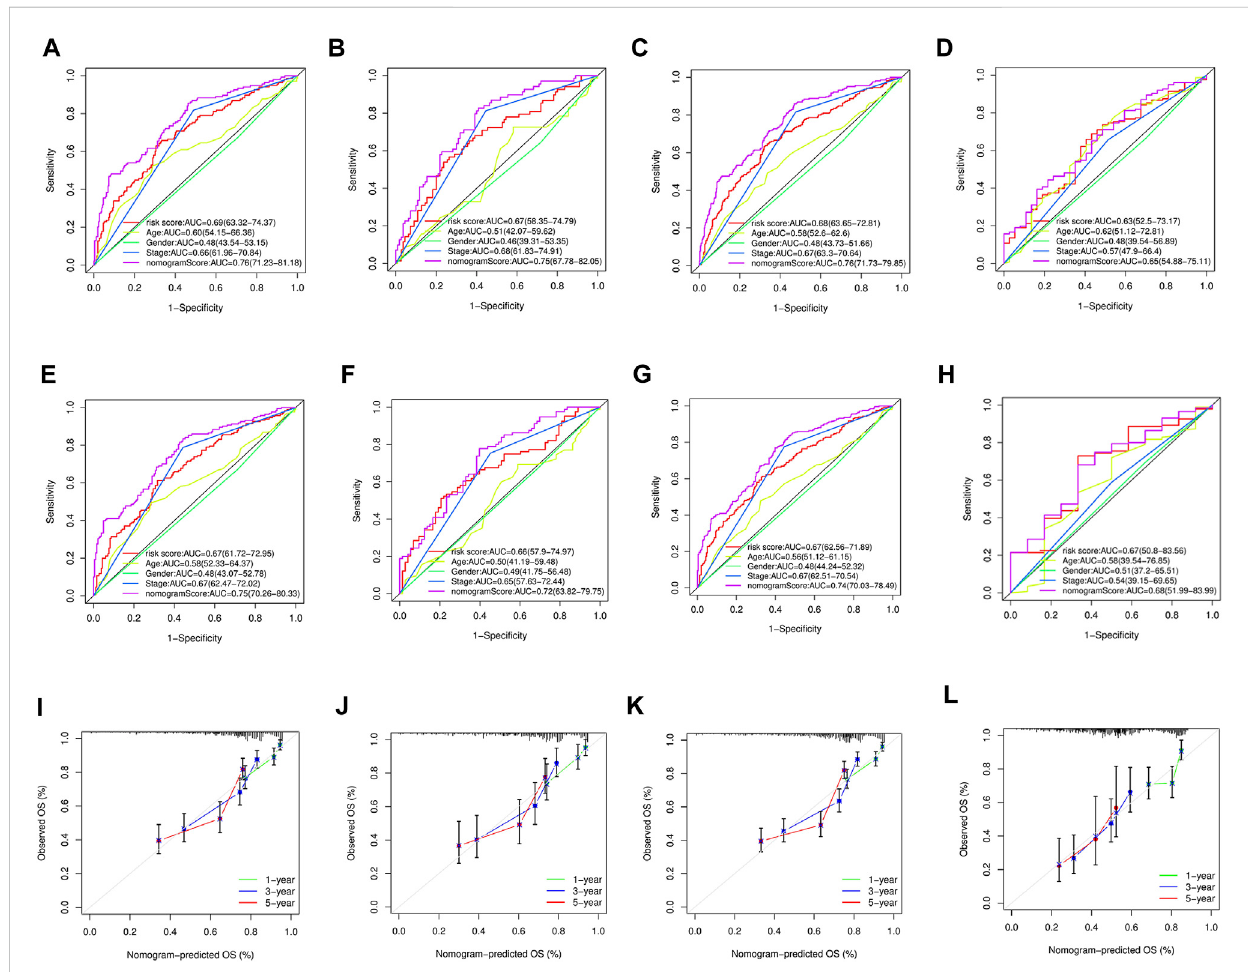
FIGURE 8 (A – D) 3 years time-dependent ROC analysis for nomogram in GC. (A) Time-dependent ROC analysis of the nomogram in the training cohort. (B) Time-dependent ROC analysis of nomogram in the test cohort. (C) Time-dependent ROC analysis of the nomogram in the entire cohort. (D) Time- dependentROCanalysisofthenomogramintheexternalcohort. (E – H) 5 yearstime-dependentROCanalysisfornomograminGC. (E) Time-dependent ROC analysisof thenomogramin thetraining cohort. (F) Time-dependent ROC analysis of nomogram inthe testcohort. (G) Time-dependent ROC analysis of the nomogram in the entire cohort. (H) Time-dependent ROC analysis of the nomogram in the external cohort. (I) The calibration plot for training cohort. (J) The calibration plot for test cohort. (K) The calibration plot for entire cohort. (L) The calibration plot for external